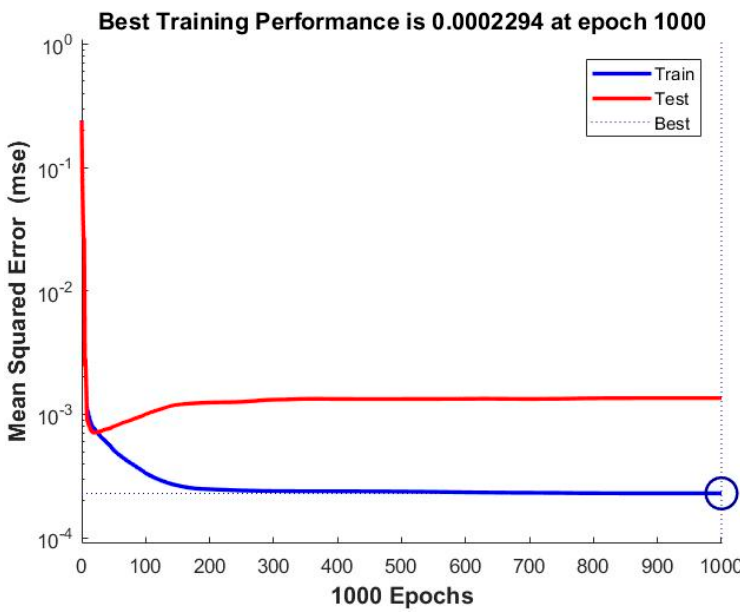
Figure 10. The best training performance when forecasting the electricity consumption for the month of December, using the ANN_NARX_BR_ALL network.